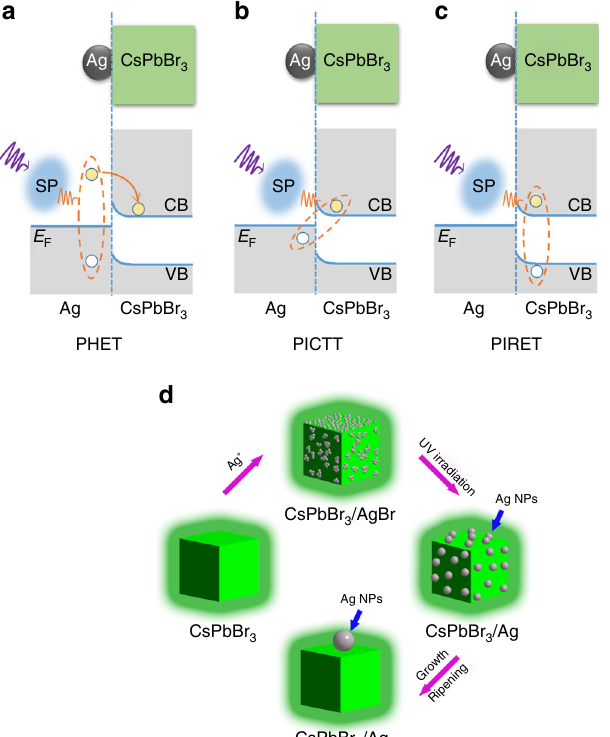
Fig. 1 Scenario of interfacial excitation transfer processes. Energy